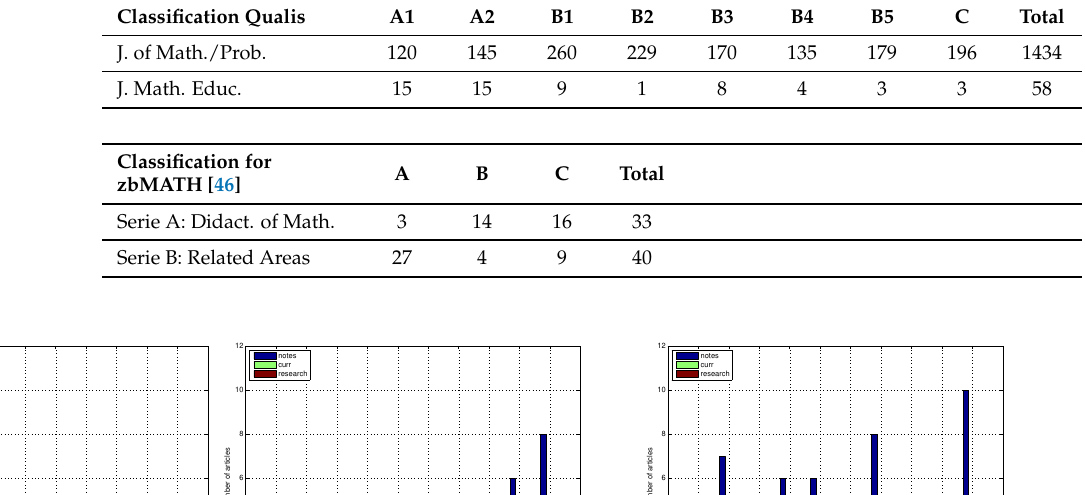
Table 1. Number of journals for Mathematics Education on Qualis and zbMATH databases, see also